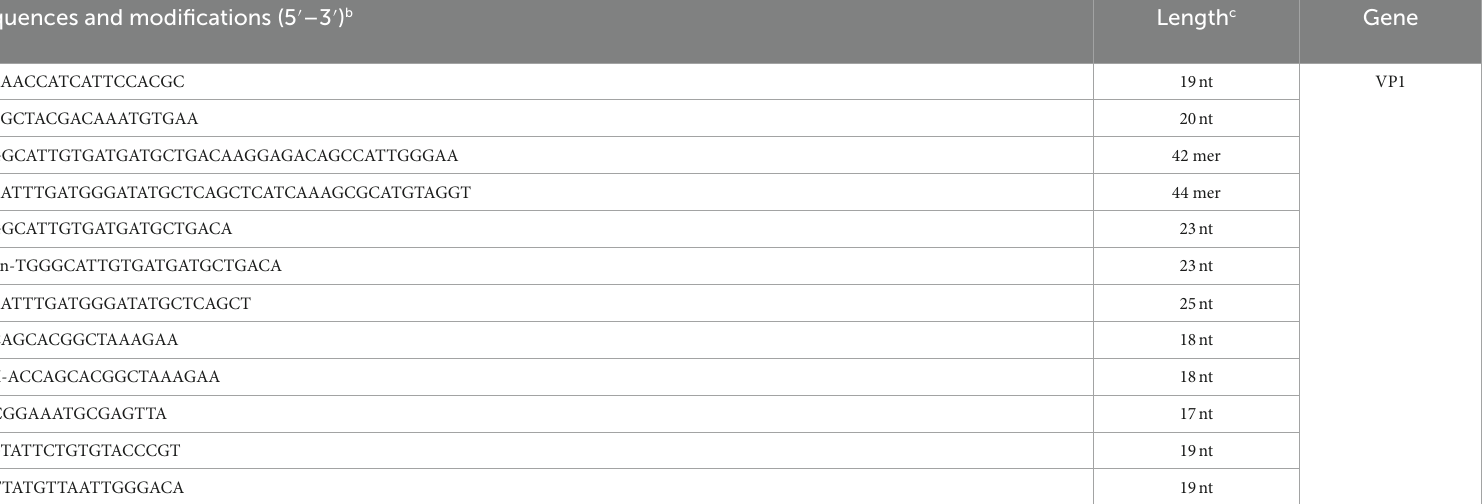
TABLE 2 The primers used in the current